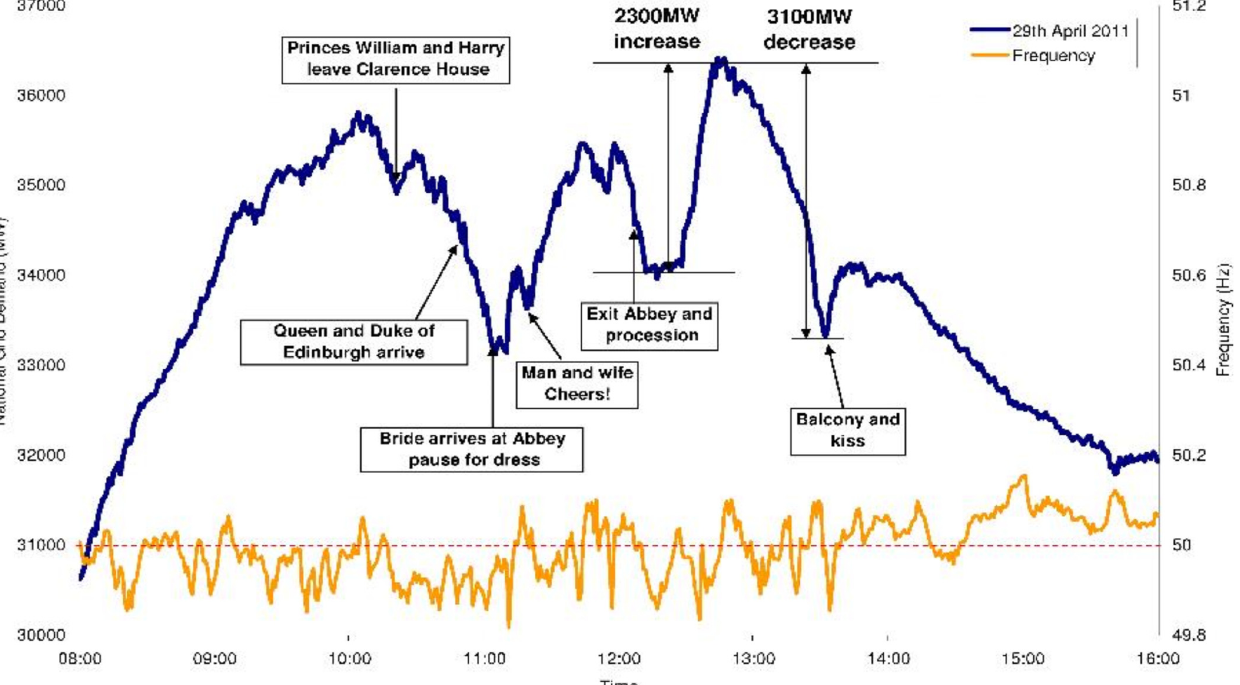
Figure 3. Change in electricity demand and system frequency in the Great Britain power system during the Royal Wedding of Prince William and Catherine on 29 April 2011 [65].